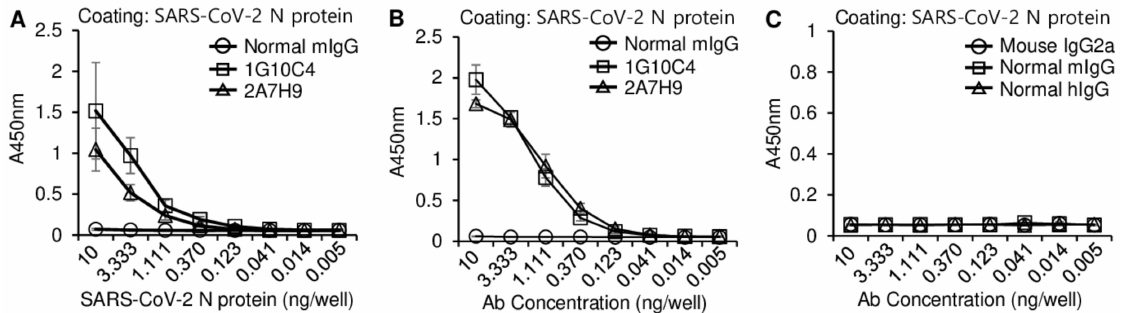
Figure 2. Detection of recombinant SARS-CoV-2 N protein with the 1G10C4 mAb or 2A7H9 mAb. An ELISA was performed to identify binding of the mAbs to recombinant SARS-CoV-2 N protein. ( A ) Ninety-six-well immuno plates were coated with serially diluted (1:3) recombinant SARS-CoV-2 N-Bio-His 6 protein, and then 100 ng/mL of normal mouse IgG (mIgG), the 1G10C4 mAb or 2A7H9 mAb was added. ( B ) Ninety-six-well immuno plates were coated with recombinant SARS-CoV-2 N-Bio-His 6 protein (100 ng/well), and serially diluted (1:3) mAbs (2A7H9 or 1G10C4) or normal mIgG was added. ( C ) Recombinant SARS-CoV-2 N-Bio-His 6 protein (100 ng/well) was used to coat 96-well plates, and serially diluted (1:3) mouse IgG2a, normal mouse IgG (mIgG), or normal human IgG (hIgG) was added. An ELISA was performed to obtain a titration